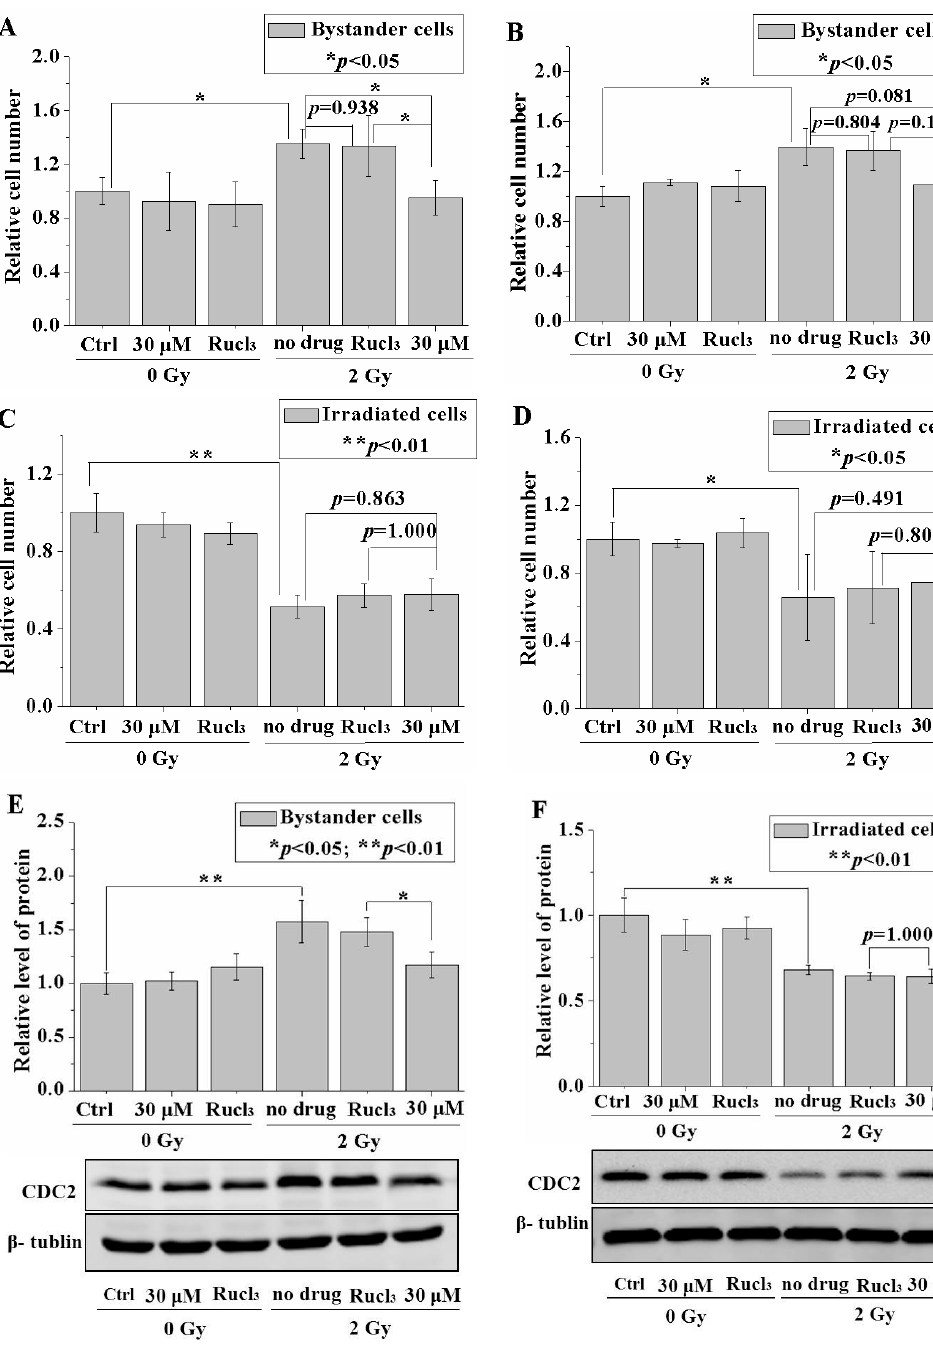
Figure 4. CO decreases proliferation of bystander cells. Relative cell number of bystander cells at 24 h ( A ) and 48 h ( B ) with or without treatment with 30 µ M CO (CORM-2); relative cell number of irradiated cells at 24 h ( C ) and 48 h ( D ) with or without treatment with 30 µ M CO (CORM-2) treatment; relative level of CDC2 protein expression in bystander ( E ) and irradiated ( F ) cells with or without 30 µ M CO (CORM-2) treatment. Data are pooled from at least three independent repeats and the results are presented as mean ± SD. Significances in the differences between the samples are determined and differences with p < 0.05 are considered statistically significant. (* p < 0.05; ** p < 0.01).